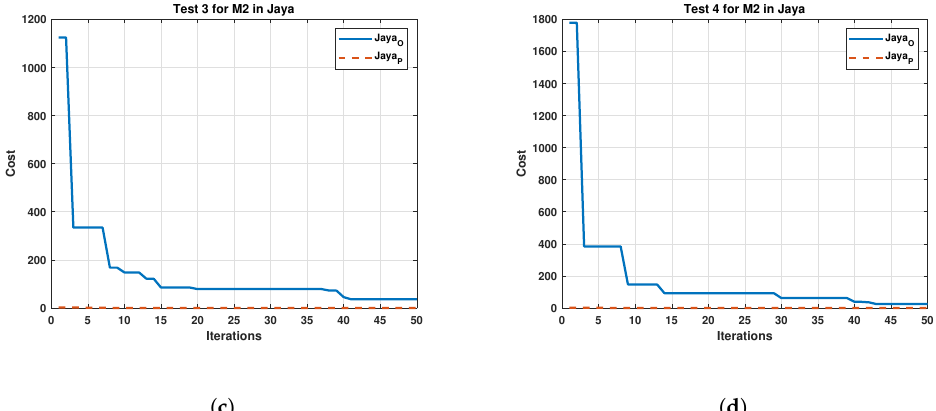
Figure 9. Comparison between the original and the proposed Jaya in four test for Motor 2. ( a ) cost and iterations of the Jaya in test 1 for Motor 2; ( b ) cost and iterations of the Jaya in test 2 for Motor 2; ( c ) cost and iterations of the Jaya in test 3 for Motor 2; ( d ) cost and iterations of the Jaya in test 4 for Motor 2.